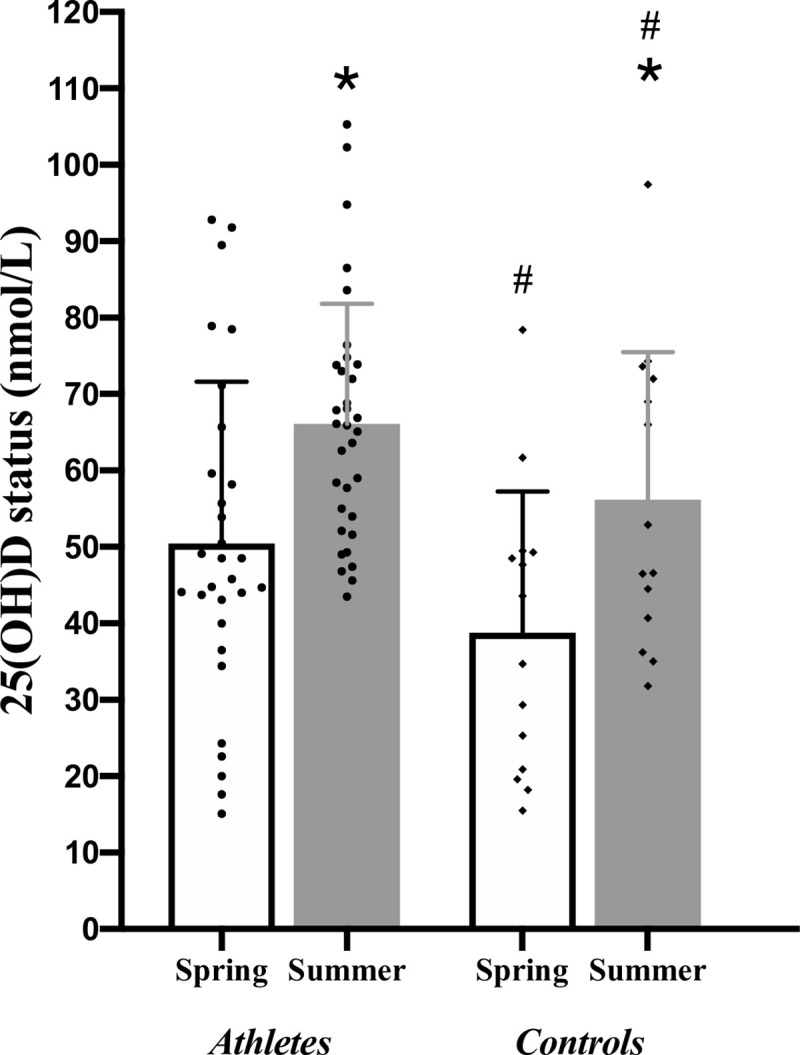
Seasonal variation in vitamin D status between the athlete and control group.*p<0.05 for the athletes/control groups between seasons. #p<0.05 between athlete and control groups in spring and summer terms.